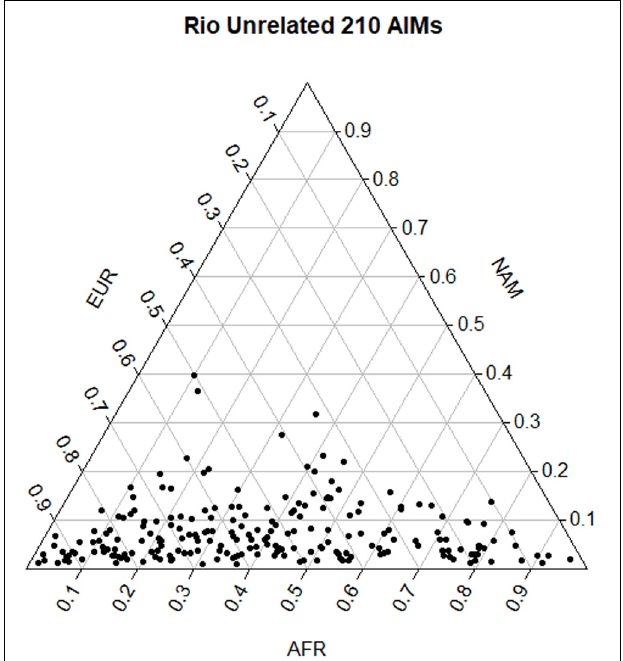
FIGURE 2 | Triangular plot of the q-matrices generated in STRUCTURE and combined in CLUMPP, considering the distribution of the three ancestry components in each